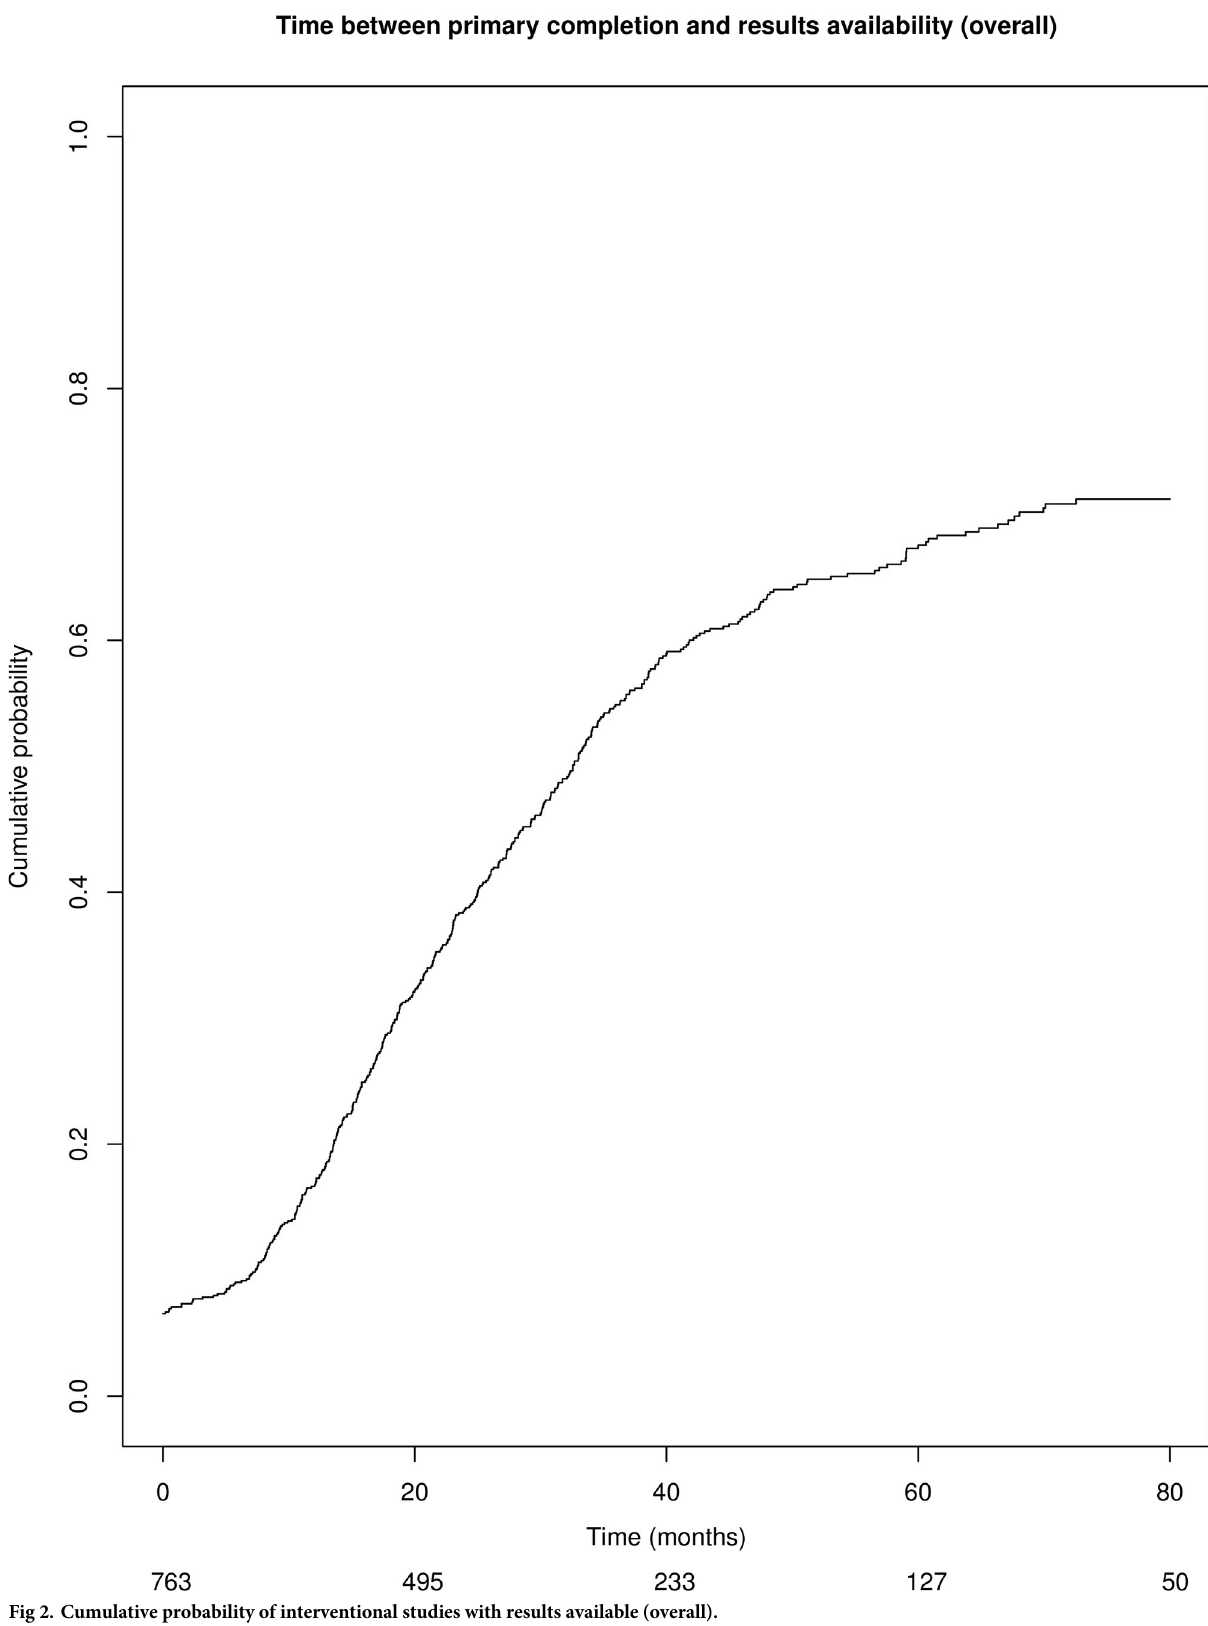
Fig 2. Cumulative probability of interventional studies with results available (overall).